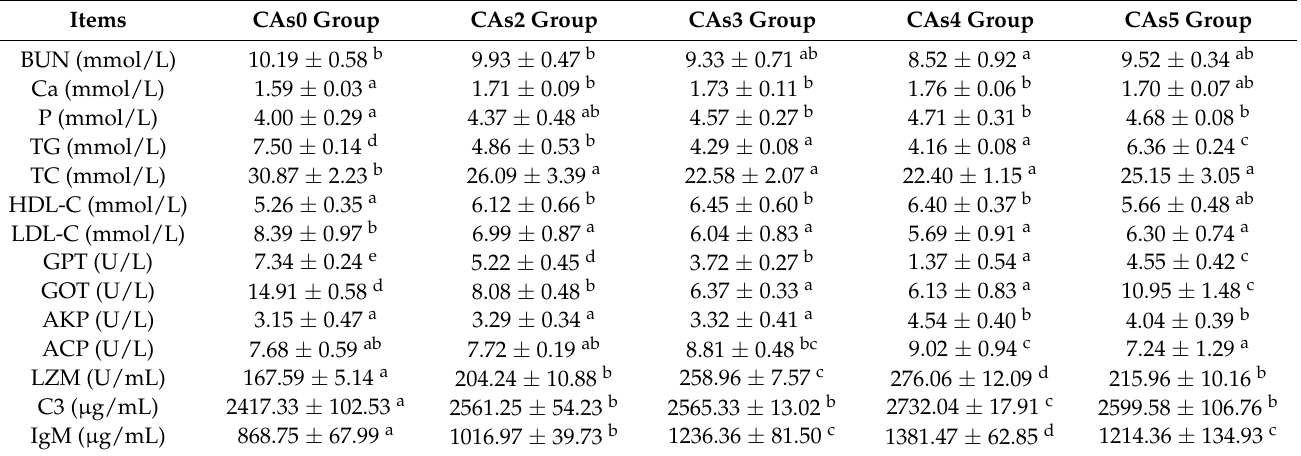
Table 2. Serum biochemical parameters of juvenile American eel in different CAs supplementation groups.